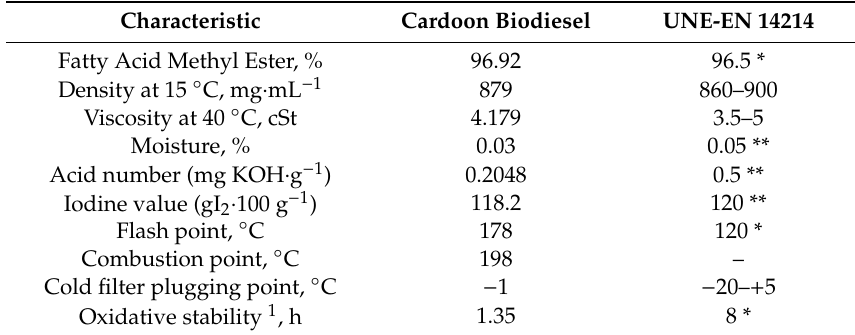
Table 2. Main characteristics of biodiesel from Cynara Cardunculus L. and comparison with the UNE-EN 14214